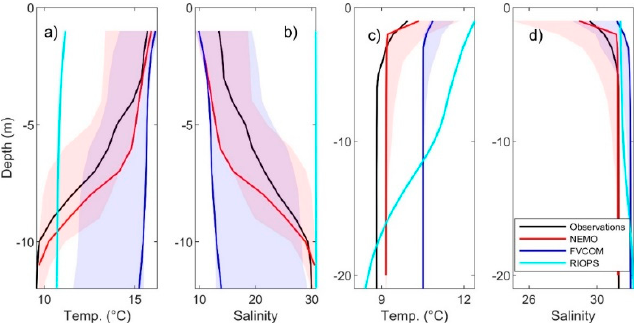
Figure 8. Observed (black) and modelled (NEMO, red; FVCOM, blue; RIOPS, cyan) temperature ( a , c ) and salinity ( b , d ) profiles from the representative stations in the inner harbour ( a , b ) and outer harbour ( c , d ). The model profiles are taken at the nearest hour to the observations, h. The shaded area around the NEMO and FVCOM profiles (light pink for the NEMO and light blue for the FVCOM) represents the profiles within t − 3 h and t + 3 h to show how the modelled profiles vary over a 6 h period. Where the areas overlap, the shading appears more purple.